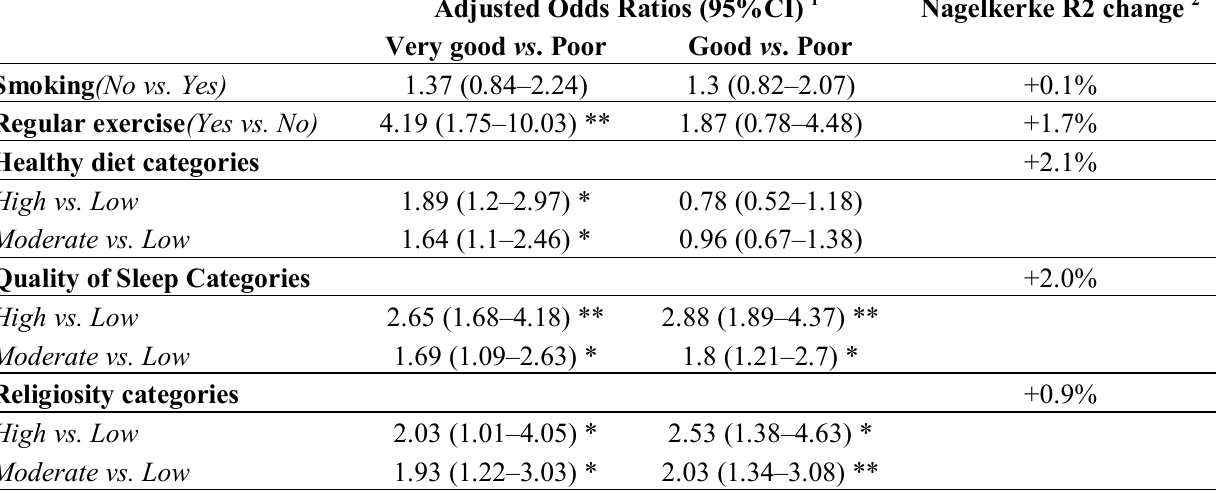
Table 3. Multinomial regression analysis of adjusted lifestyle factors with SRH as dependent variable (N =